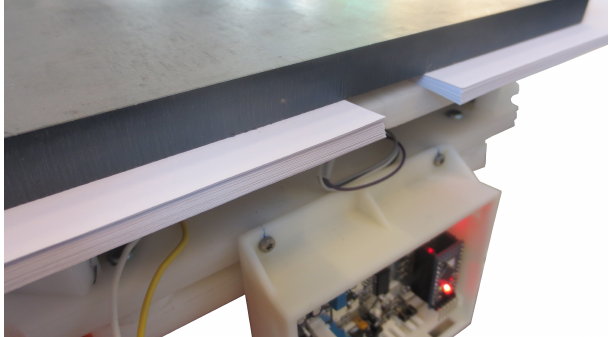
Figure 8. Distancing the electromagnets from the target using plain A4